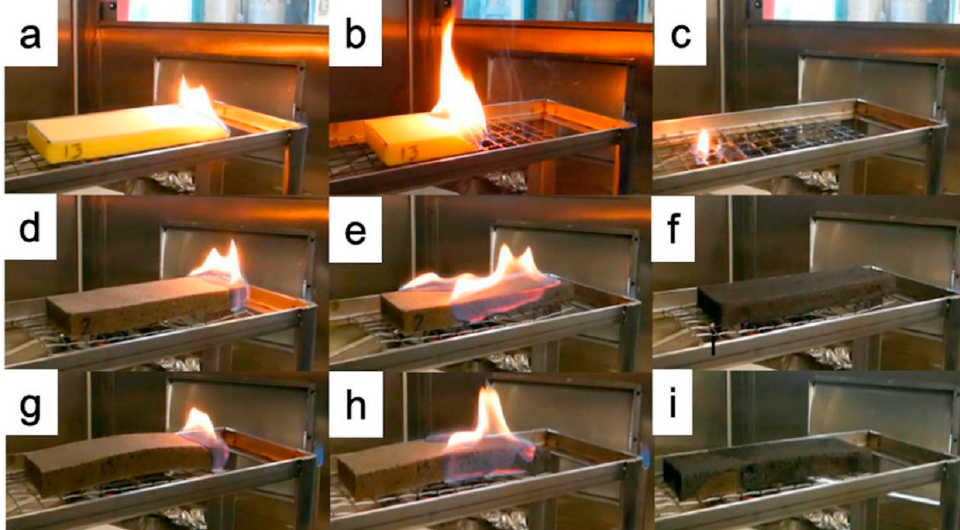
Figure 29. Pictures of horizontal flame spread tests of untreated polyurethane foam ( a – c ), foam coated with 3 chitosan/graphene oxide bi-layers ( d – f ) and foam coated with 6 chitosan/graphene oxide bi-layers ( g – i ). First column, right after ignition; second column, 15 s after ignition; third column, during flame out. Reprinted with permission from [56]. Copyright 2018, Elsevier.